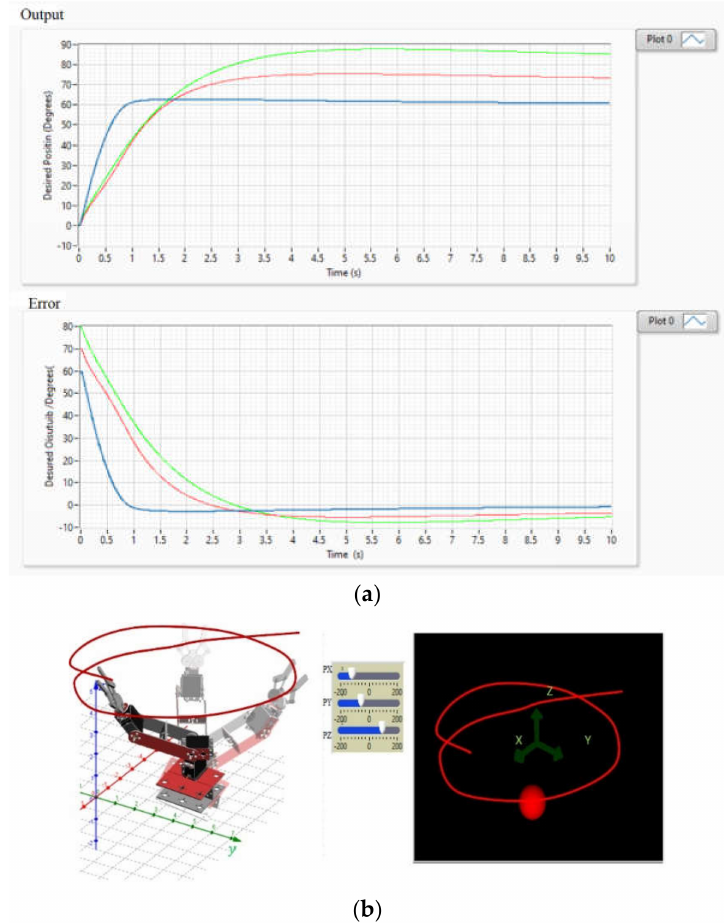
Figure 17. ( a ) Graphs of the position error with a tendency to zero for each of the joint coordinates (cid:0) (cid:1) q ,q ,q and control curves indicating the operation of the PD+ to reach the desired positions, 1 2 3 ( b ) Result of the PD+ trajectory control of an anthropomorphic virtual